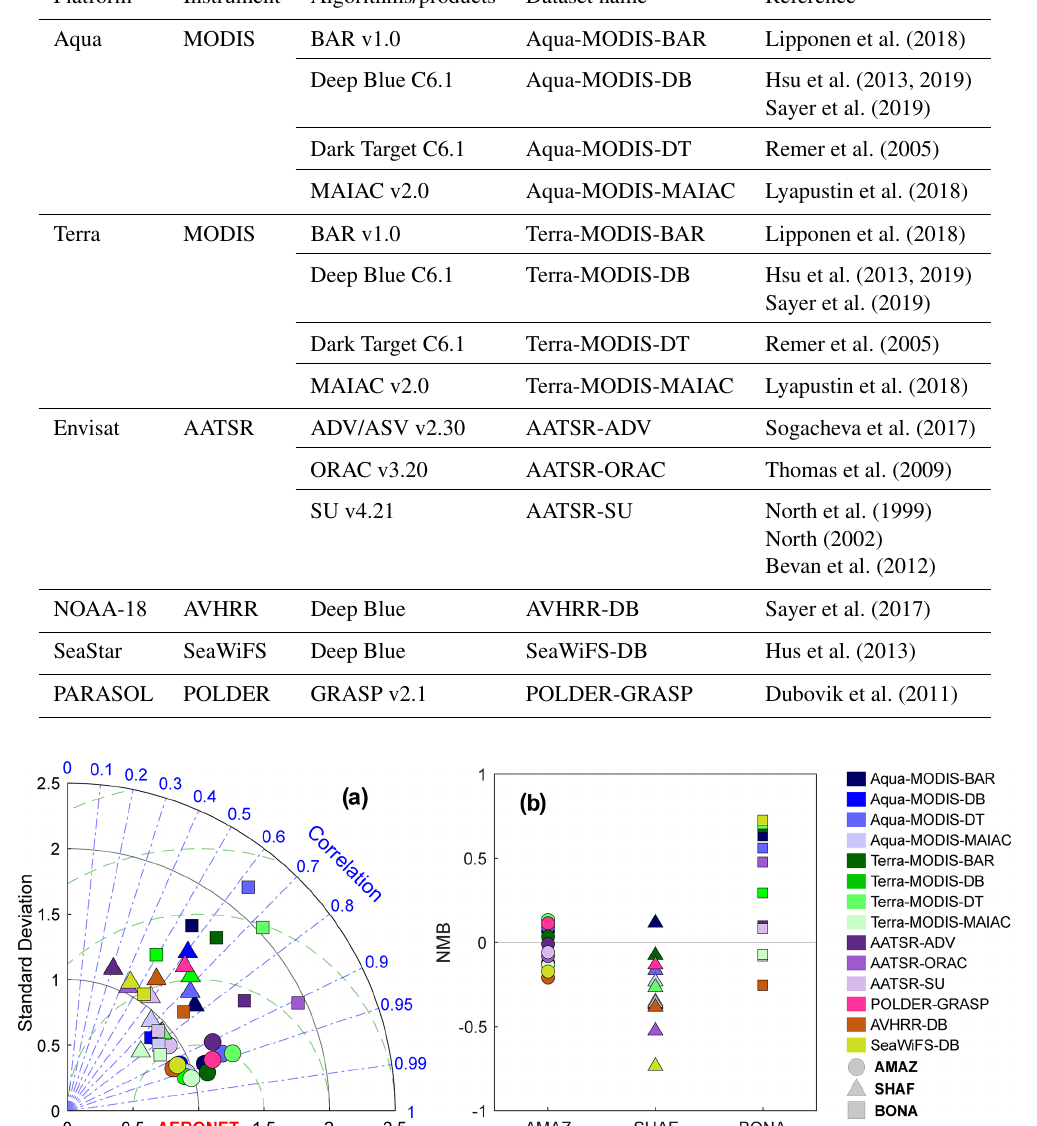
Figure 2. Comparison of the 14 satellite AOD products against AERONET observations as shown by a Taylor diagram (a) and scatter diagram of NMB (b) . The colors and shapes of dots indicate different satellite datasets and fire regions. All the satellite data were individually collocated with AERONET data during the fire seasons. POLDER-GRASP and SeaWiFS products over BONA are not shown because the available sample size was too small ( < 5) after